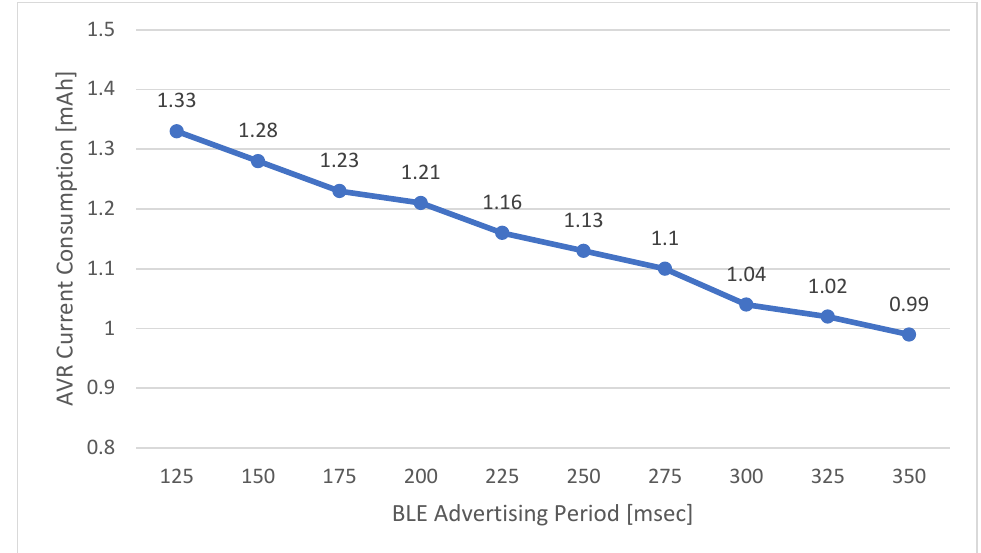
Figure 18. Average Power Consumption of ADL Report Protocol (Mobile Identification Device (MID)).